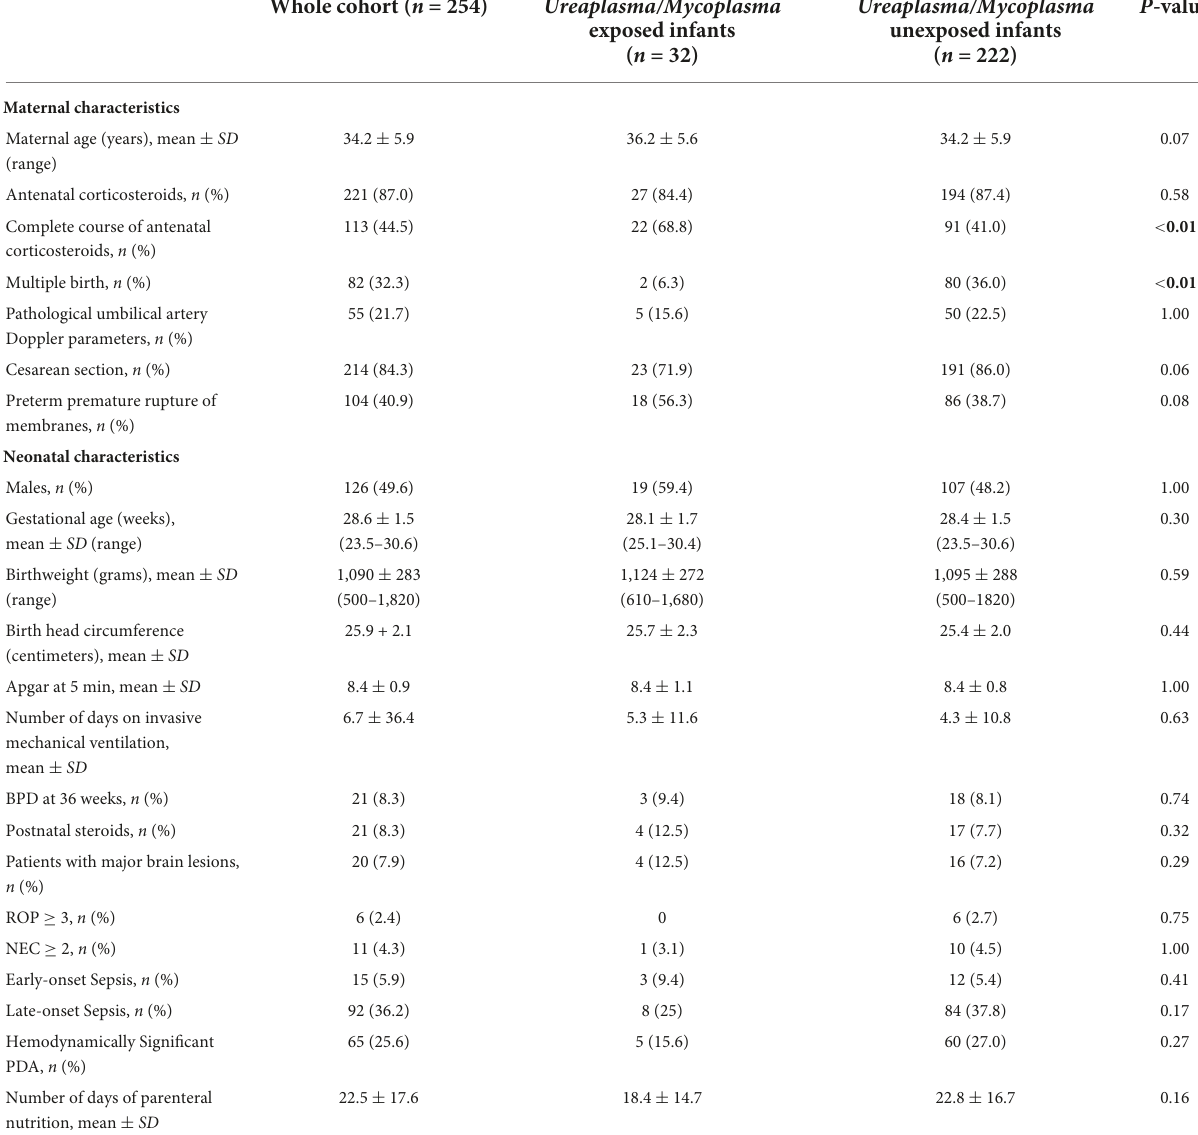
Whole cohort ( n = 254) Ureaplasma/Mycoplasma